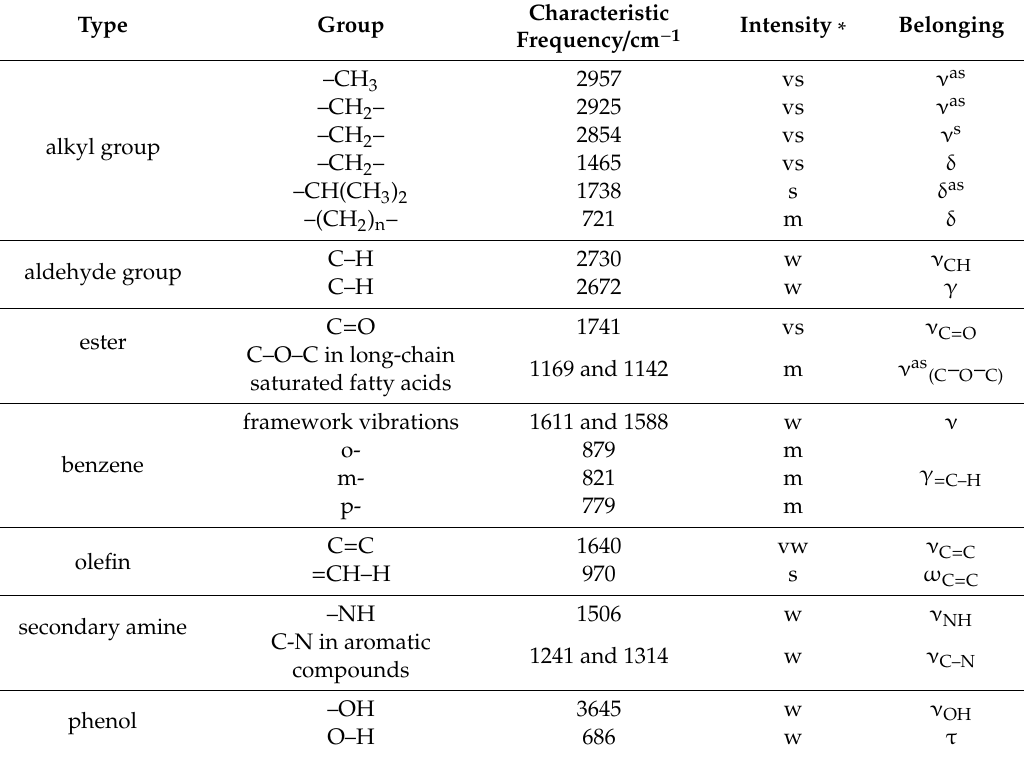
Figure 1. FT-IR spectra of S rt , S 180 , S 200 , S 230 , S 250 , S 270 , and S 300 . Table 1. FT-IR spectra assignments for S rt , S 180 , S 200 , S 230 , S 250 , S 270 , and S 300 .